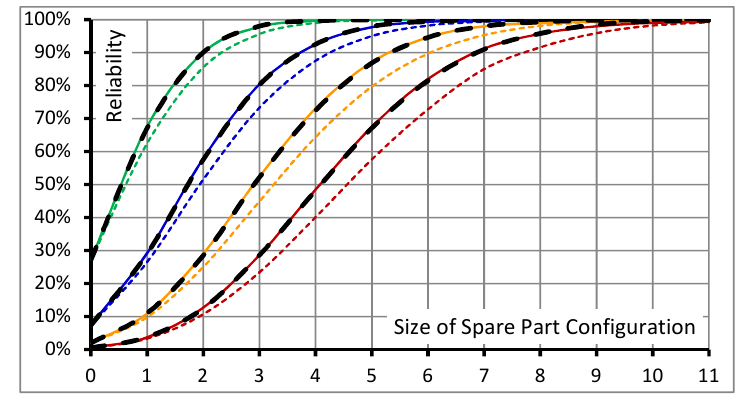
(𝑇|𝑁 ) for an unreliable part. (cid:3036) (cid:3036) (𝑇|𝑁 ) obtained (cid:3036) (cid:3036)